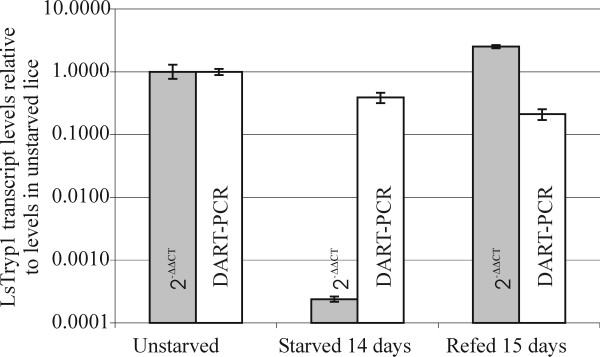
Q-PCR analysis. Transcript levels from the same Q-PCR runs analysed using the 2-ΔΔCT method and the DART-PCR Excel Spreadsheet. Error bars indicate 95% confidence intervals.